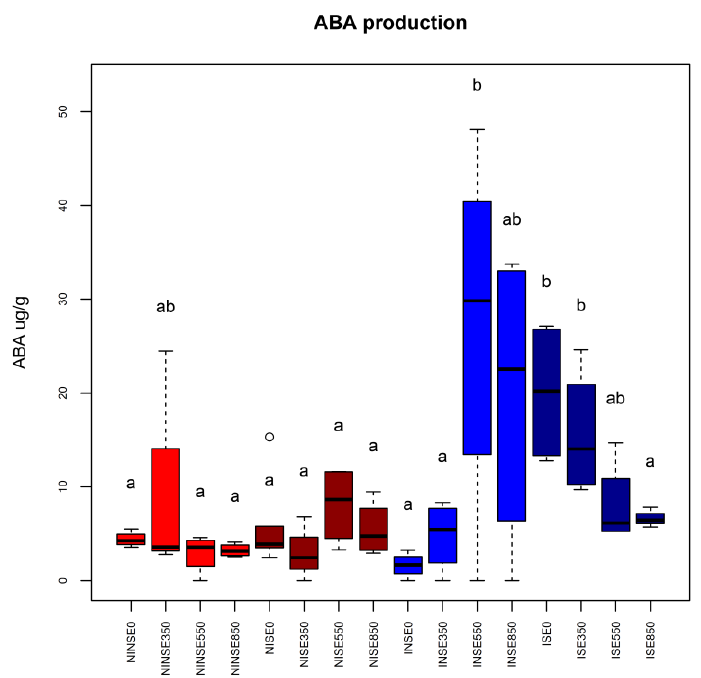
Figure 2. Boxplots representing abscisic acid (ABA) production in the different conditions (NI, I: not-inoculated and inoculated plants, respectively; S, NS: water stressed and non-stressed plants; E0, E350, E550, E850: different ethephon concentrations in ppm). Different conditions were color coded as follows: red and brown boxes represent not-inoculated plants (NI) non-stressed (NS) and water stressed (S), respectively, while blue and dark-blue boxes represent inoculated plants (I) non-stressed (NS) and water stressed (S), respectively. Letters are plotted according to outcomes of Tukey’s test.